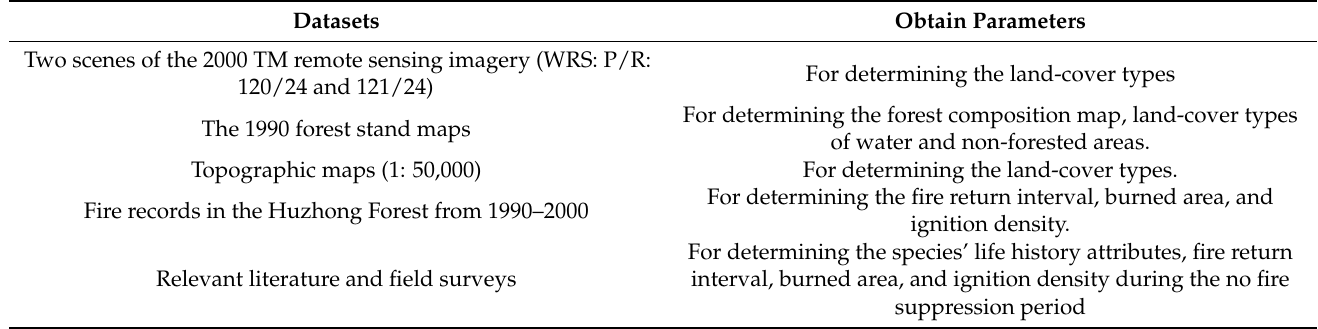
Table 1. Use of datasets in the parameterization